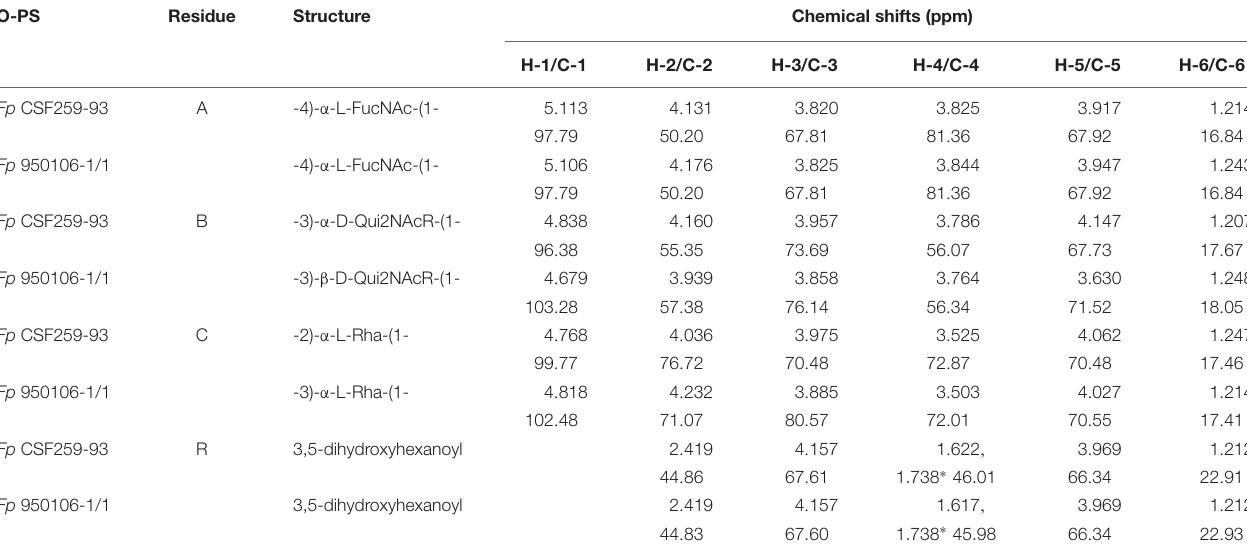
TABLE 2 | Residue by residue comparison of HSQC 1 H and 13 C chemical shifts of Fp CSF259-95 and Fp 950106-1/1 O-PS. O-PS Residue Structure Chemical shifts (ppm)